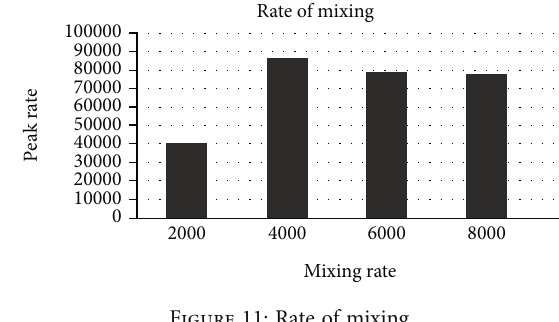
Figure 9: Graph of extraction